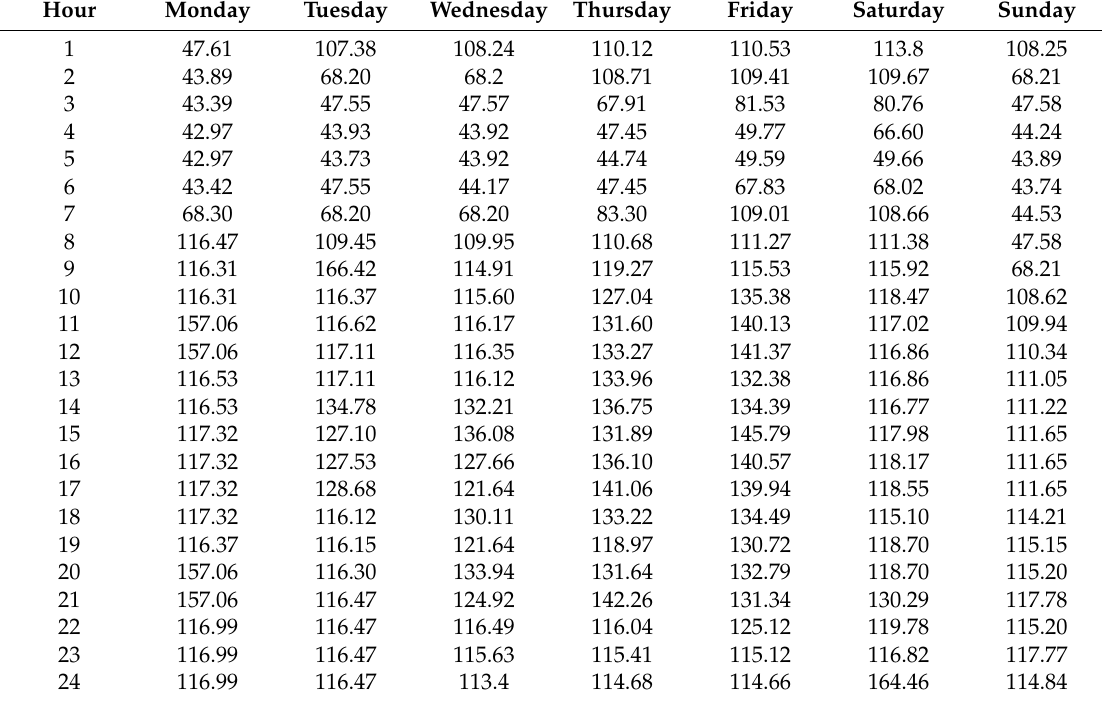
Table A2. Energy prices for peak shaving and load leveling (KRW/kWh)